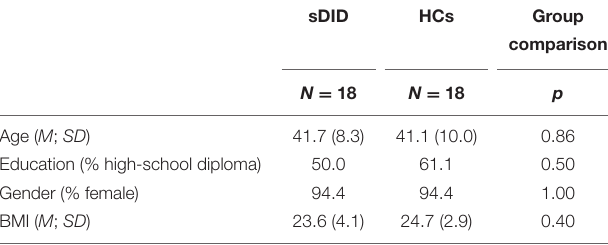
TABLE 1 | Sociodemographic data and sample characteristics.